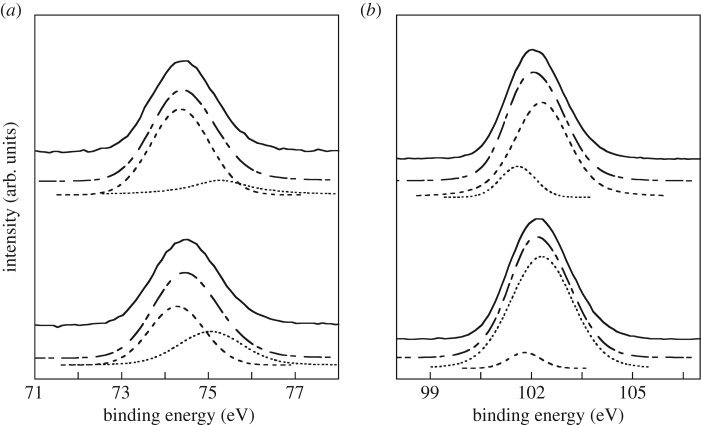
(a) Al2p and (b) Si2p XPS spectra. Solid, dashed and dash-dotted lines represent original, fitted and the sum of fitted spectra, respectively.